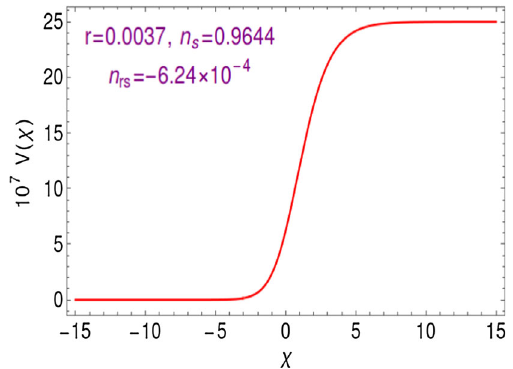
Fig. 8 Inflation potential in the Planck unit for ζ H = 1 and λ 2 = 10 −